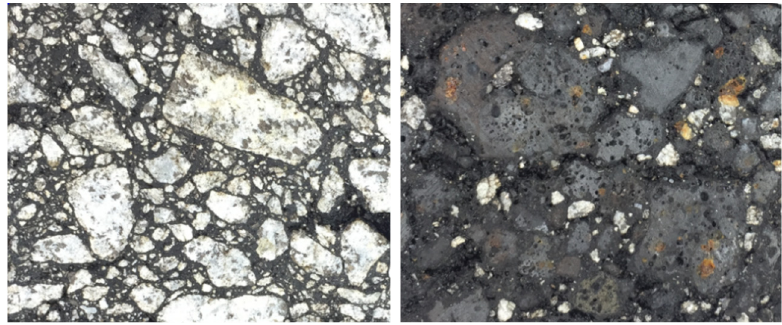
Figure 2. AC 20 bin/base mixture with natural granitic aggregates ( left ) and equivalent asphalt mixture with 75% SSA ( right ).